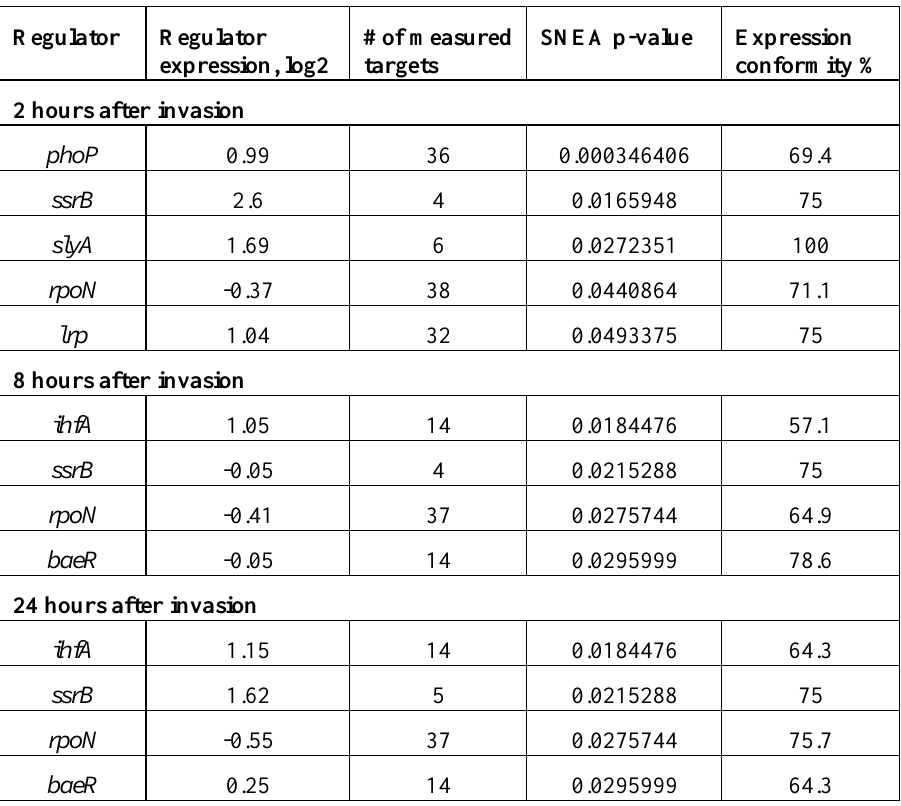
Table 4: Most significant transcription factors identified by sub-network enrichment analysis (SNEA) from the time course of Salmonella invasion of human macrophages. pValue of SNEA indicates statistical significance of differential expressed downstream genes targeted by the transcription factors. This in turn signifies the activity of the transcription factor in the experiment. Expression data was obtained from Gene Expression Omnibus at NCBI (GEO accession number GSE3096). Expression conformity shows how many targets are up- or down-regulated in the right direction relative to the reported activity of the transcription factor (which can be activator or repressor) towards the